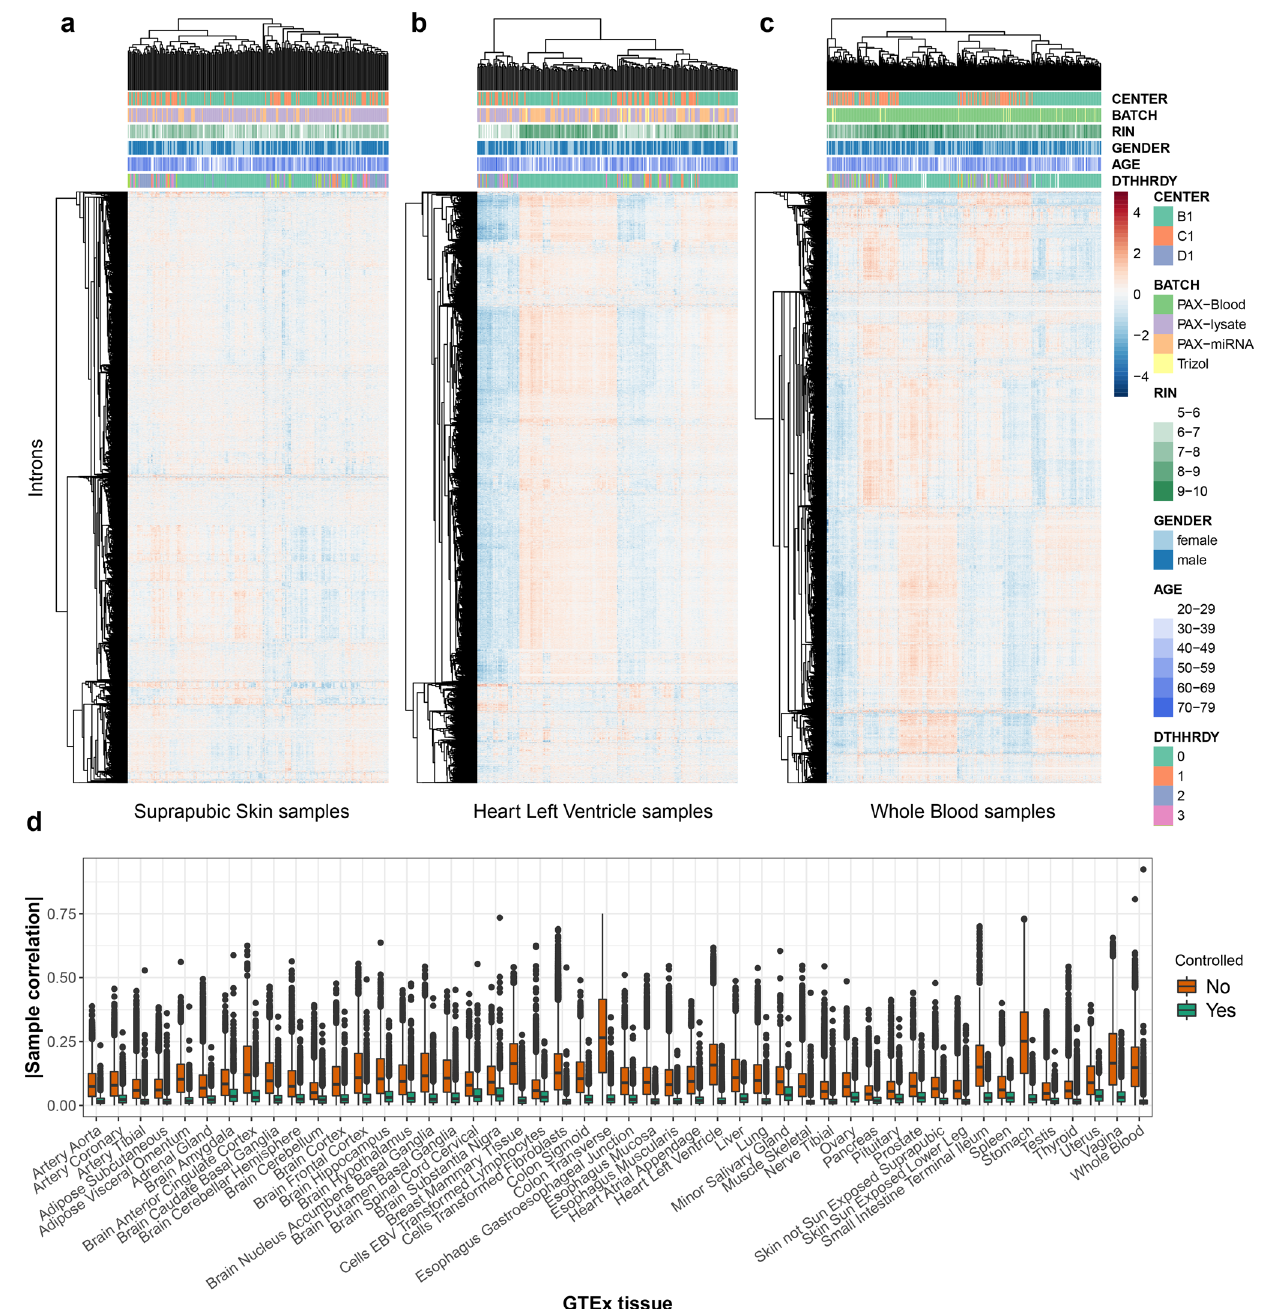
Fig. 2 FRASER corrects for covariations in alternative acceptor usage. a – c Intron-centered and logit-transformed ψ 5 of the 10,000 most variable introns clustered by samples (columns) and introns (rows) for three representative GTEx tissues: suprapubic skin ( a , n = 222), left ventricle heart ( b , n = 211), and whole blood ( c , n = 369). The red and blue colors indicate relative high and low intron usage, respectively. Colored horizontal tracks display sequencing center, batch, RNA integrity number (RIN), gender, age, and cause of death (DTHHRDY, Hardy scale classi fi cation) of the samples. d Boxplots of absolute values of between-sample correlations of intron-centered logit-transformed ψ 5 for 48 GTEx tissues before (orange) and after (green) correction for the latent space ( n = number of sample pairs per GTEx tissue, between 52 and 401 samples per tissue, for more details, see Supplementary Fig. S1E). The ψ 5 values were clipped to the [0.01, 0.99] interval before logit-transformation. These plots show that while tissue-speci fi c correlation structures exist among samples, latent space fi tting allows correcting for them. The data in d are represented as boxplots in which the middle line indicates the median, the bounds of the box indicate the fi rst and third quartiles and the whiskers indicate ±1.5 × IQR (interquartile range) from the third and fi rst quartile, respectively. Outlying data points are shown as